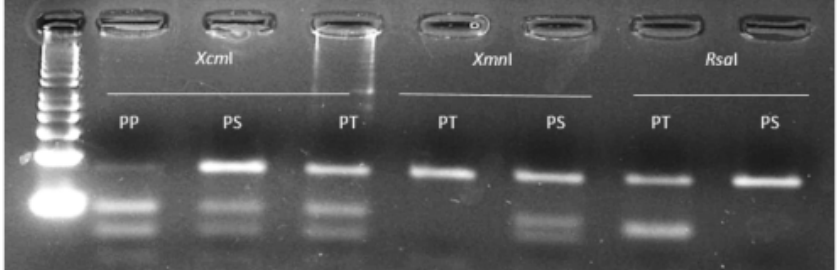
Table 3. Sequencing and dPACS primers employed and corresponding PCR products and restriction digests. The forced nucleotide mismatches on the primers are in bold and underlined.